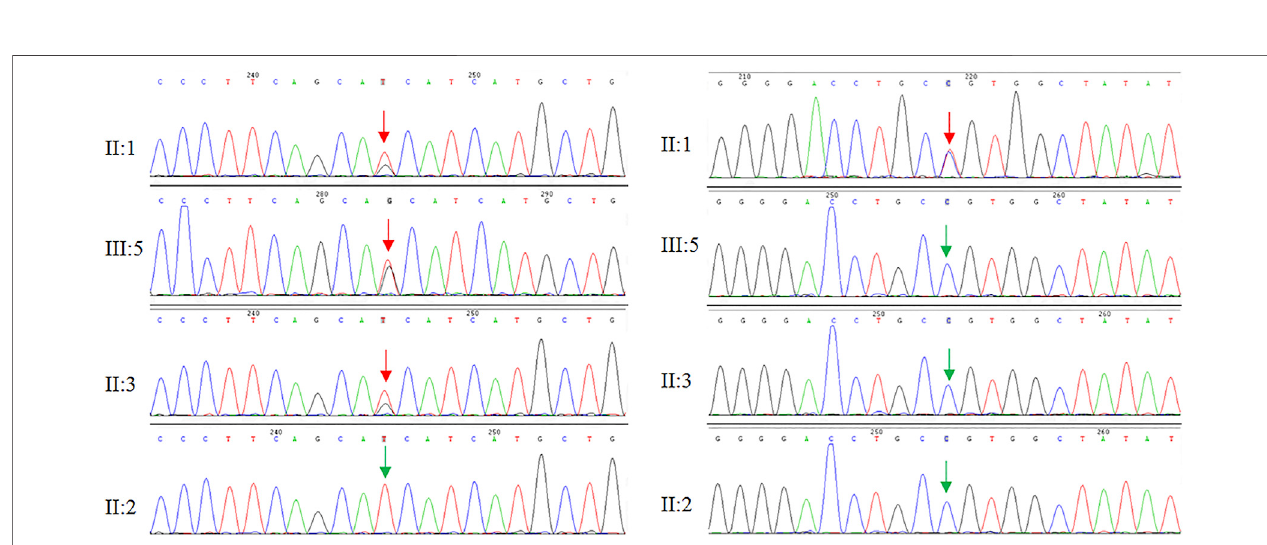
FIGURE 2 | Brain magnetic resonance imaging (T2-weighted) shows diffuse leukoencephalopathy (A) ; Brain magnetic resonance (T2-weighted) shows cerebellar atrophy (B) .